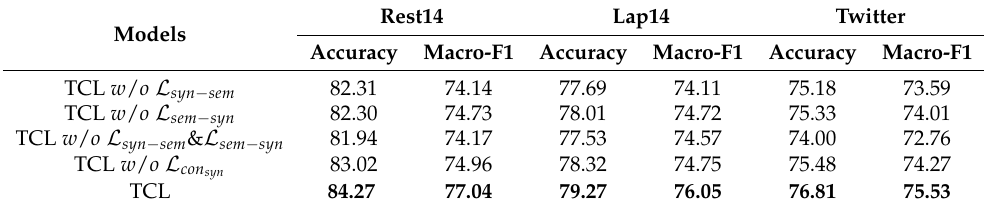
Table 3. Ablation study results. Bold numbers represent the best results.